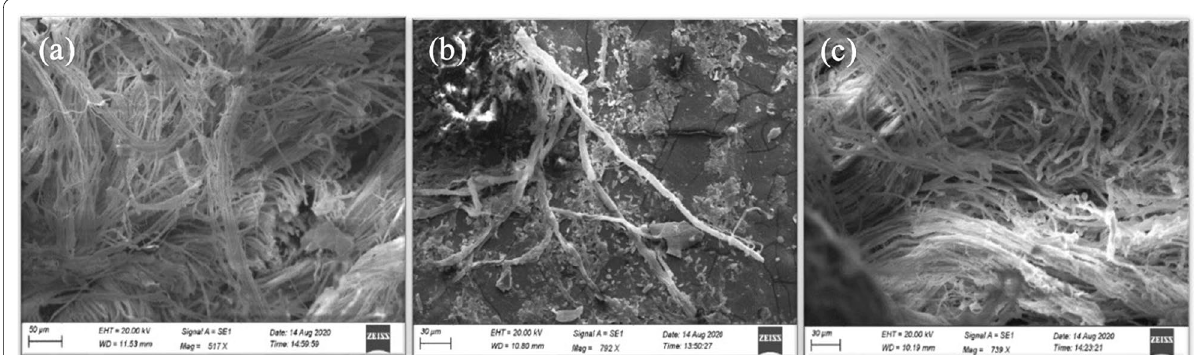
Fig. 5 SEM images of vegetable tanned leather a control, b fungi infected, c fungi infected with UV exposure sample after 30 days